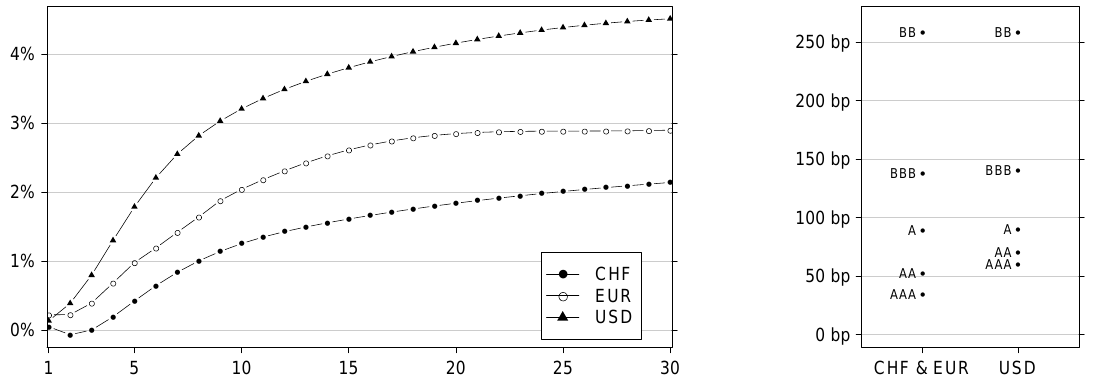
Figure 3. Zero-coupon rates r w , t (lhs) and credit spreads s w , r (rhs) considered for the case